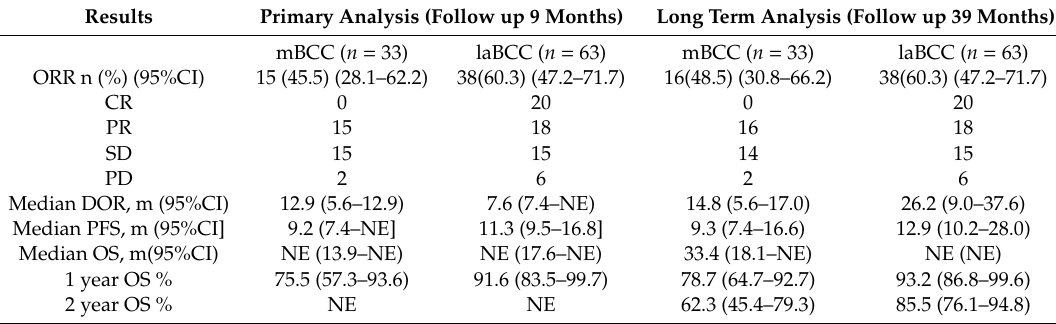
Table 1. E ffi cacy of Vismodegib in ERIVANCE trial (investigator